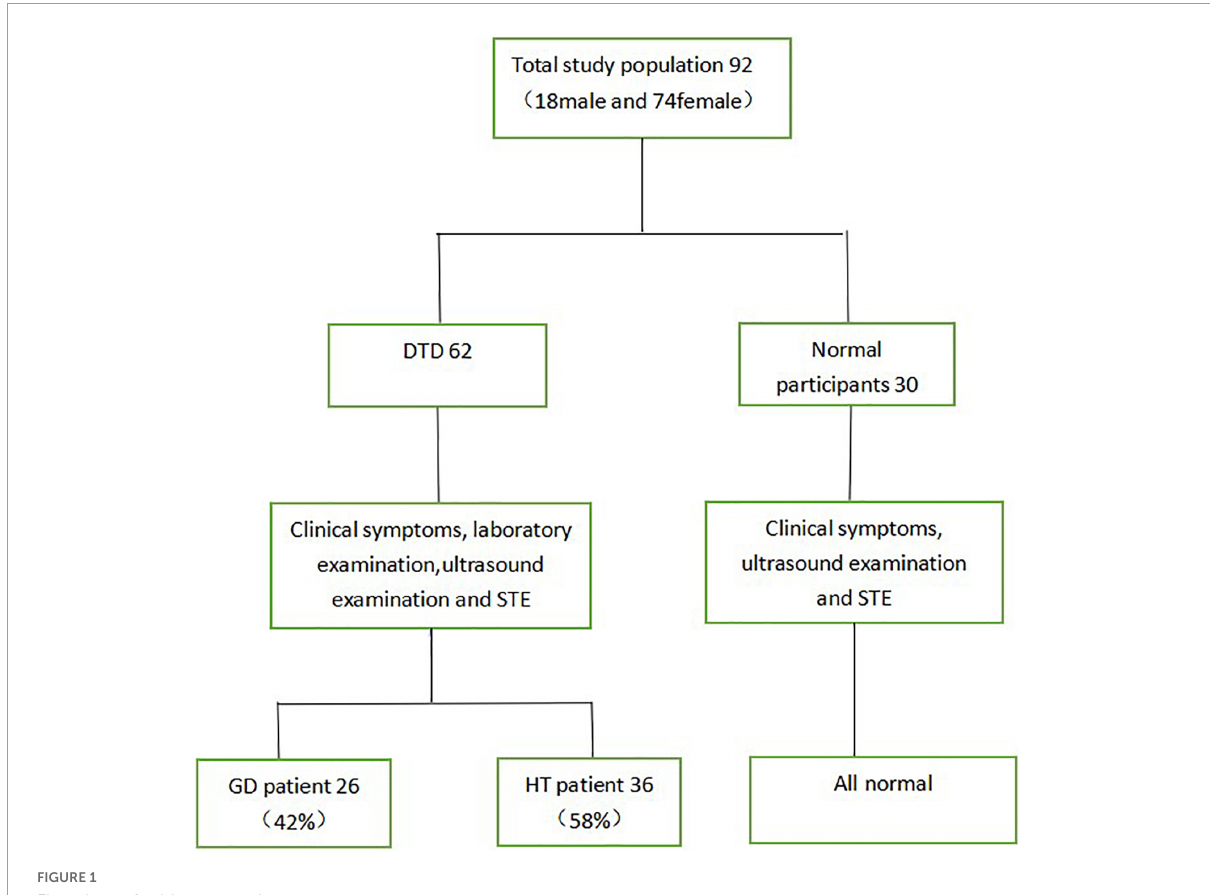
FIGURE1 Flowchart of subject screening.